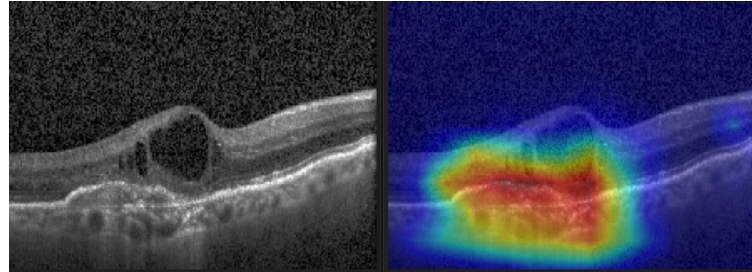
Figure 12. CNV and its